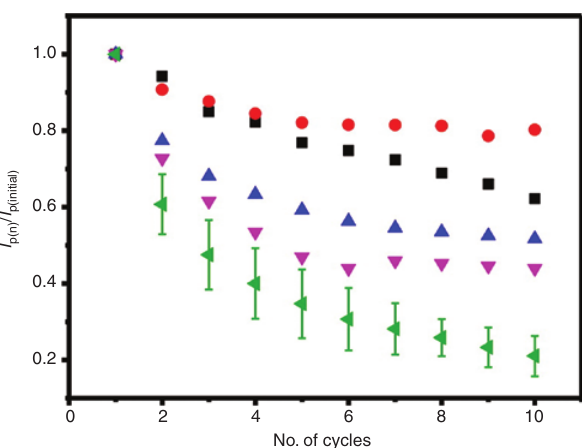
/ I against number of cycles ( n ) for the electrooxi- Figure 2: I p(n) p(initial) dation of dopamine at polycrystalline boron-doped diamond (red), glassy carbon (black), edge plane pyrolytic graphite (blue), basal plane pyrolytic graphite (pink), and basal plane highly oriented pyrolytic graphite